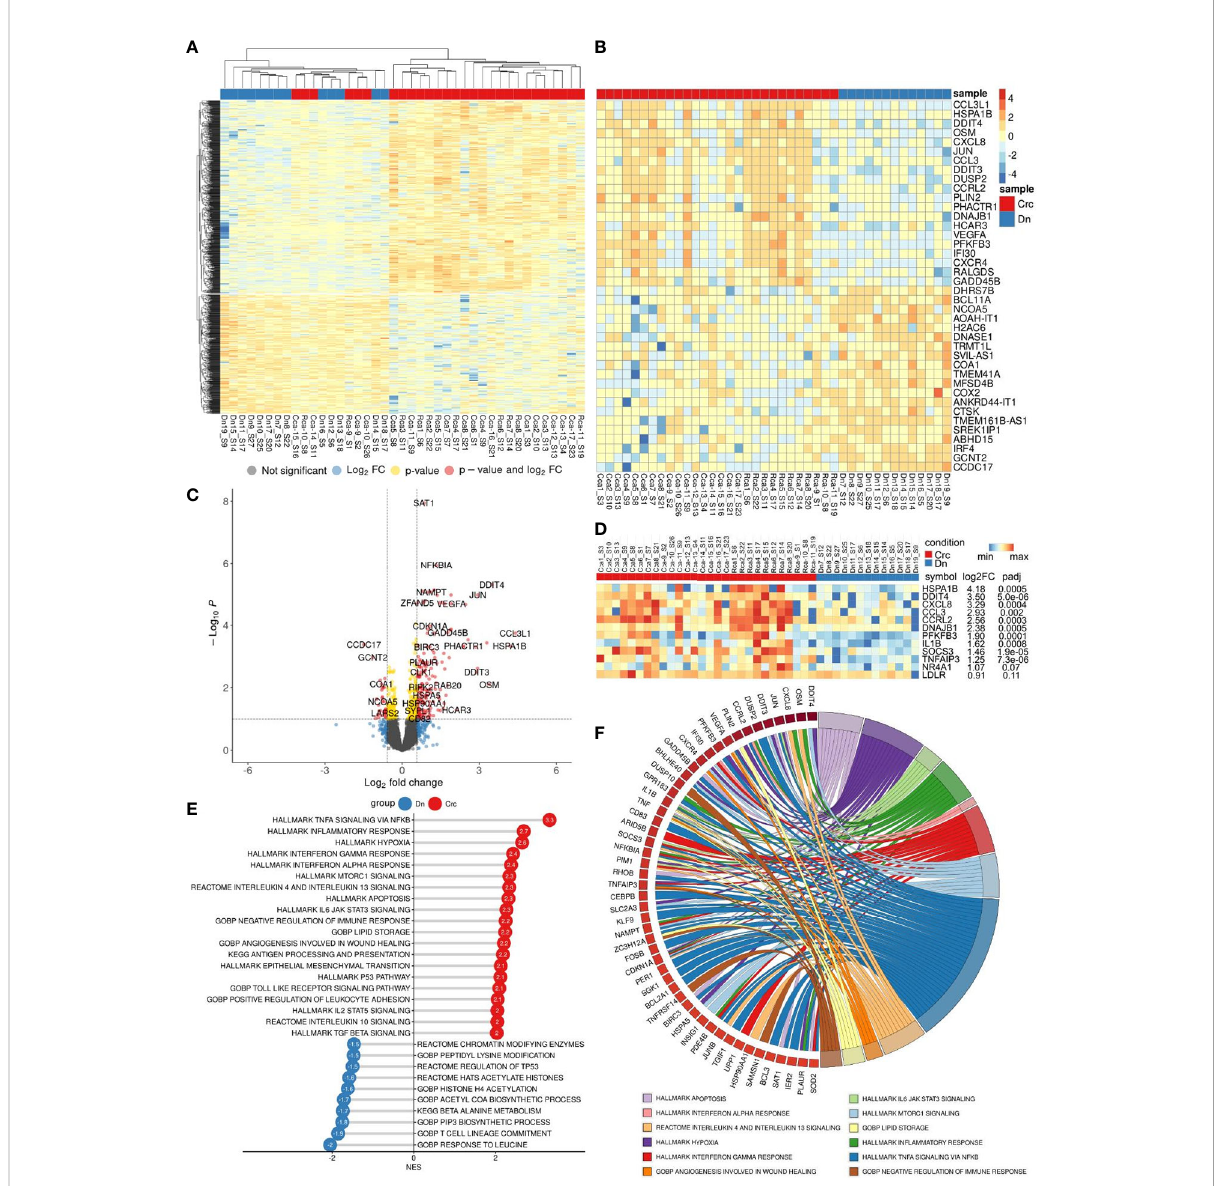
FIGURE 3 Comparative transcriptome of monocytes from CRC patients (Crc) and healthy donors (Dn). (A) , Heatmap demonstrates hierarchical clustering of samples and upregulated and downregulated genes in monocytes of CRC patients (FDR<0.25). (B) , Heatmap with top 20 DEGs upregulated and downregulated in monocytes of CRC patients (FDR<0.1). (C) , Volcano plot shows p-value and log2 fold-change value for DEGs in monocytes of CRC patients (|L2FC|>0.58, FDR<0.1). (D) , Set of genes from DEA analysis selected for RT-PCR validation. (E), Bar plot with GSEA results demonstrates top deregulated pathways in monocytes of CRC patients (FDR<0.1). (F) , Chord plot demonstrates top upregulated pathways (FDR<0.01) and their top enriched genes (FDR<0.05) in CRC